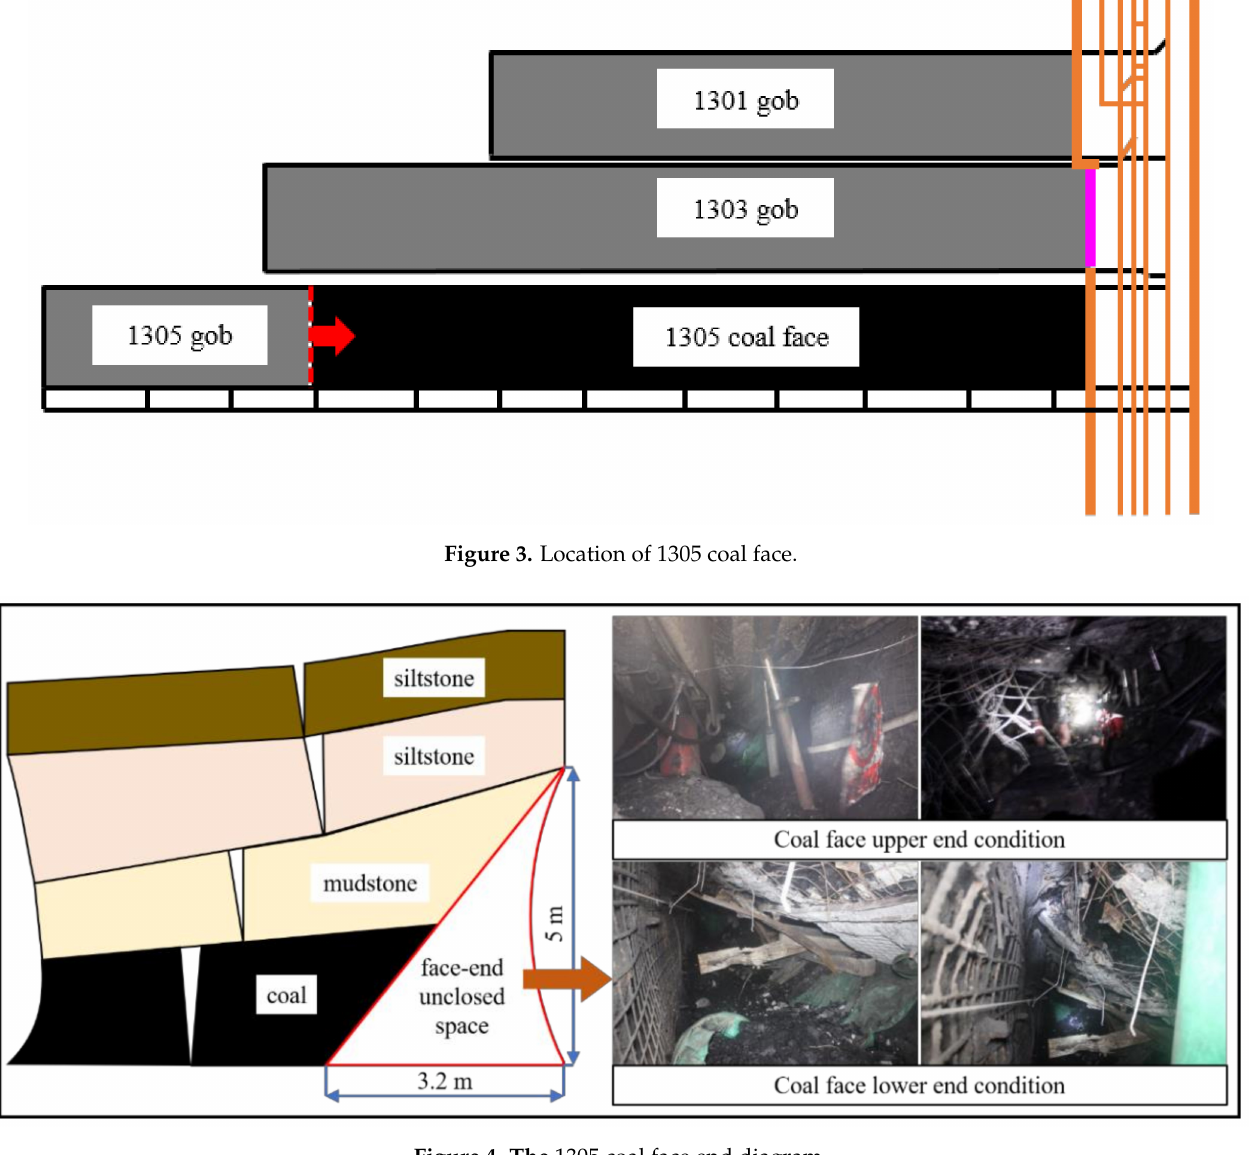
Figure 4. The 1305 coal face end